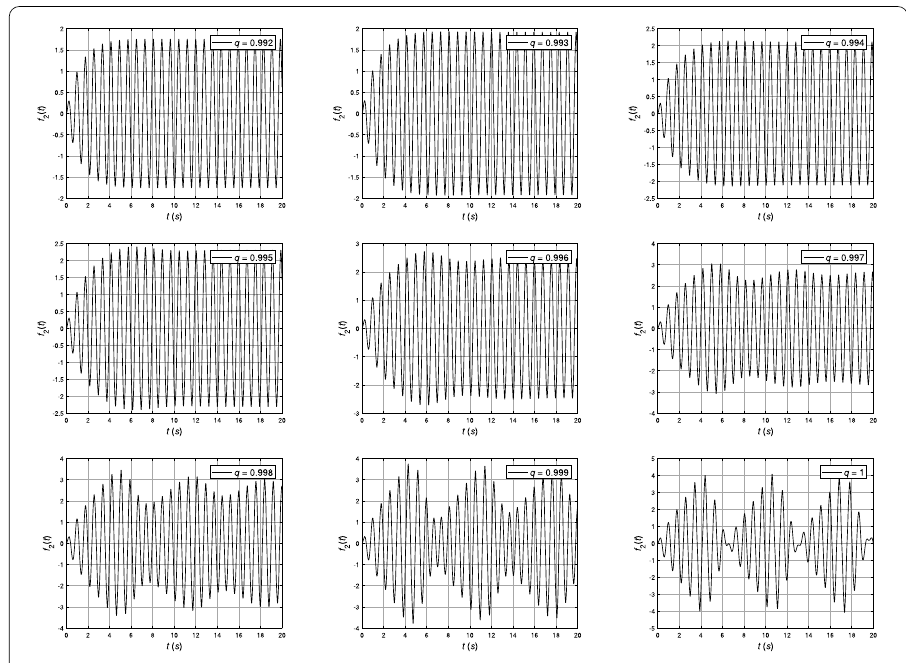
Figure 2 The state variable f 2 ( t ) of the fractional suspension system (13) for q = 0.992,0.993,0.994,0.995,0.996, 0.997,0.998,0.999,1